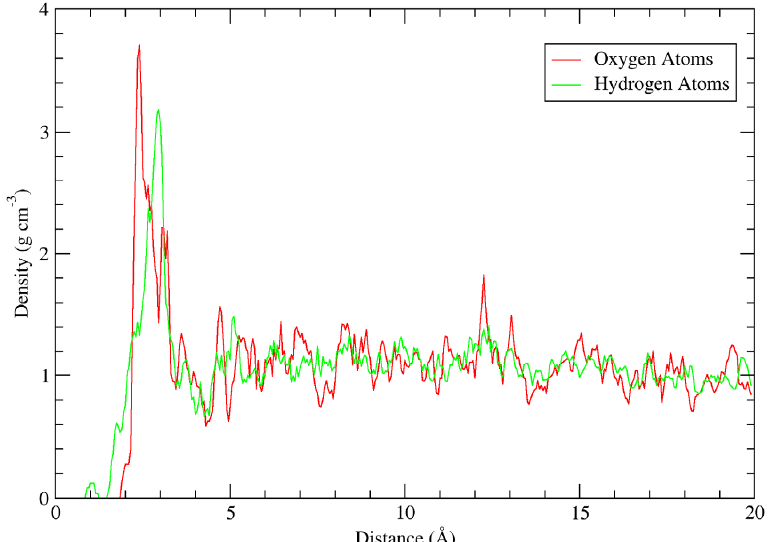
Figure 4. Density of water oxygen (red) and hydrogen (green) atoms at various radial distances, normalised to 1 g cm − 3 .